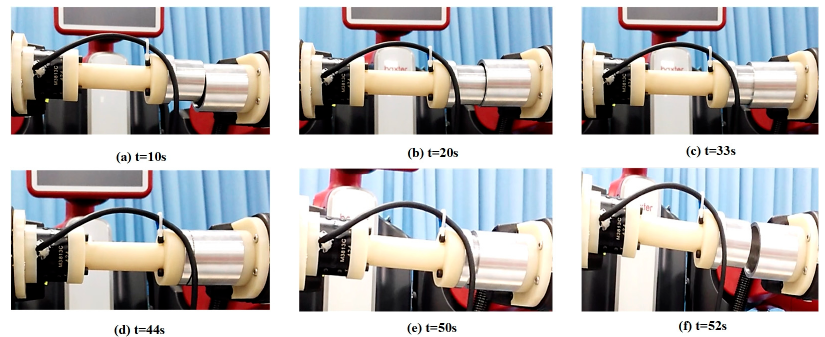
Figure 13. Round pieces: the process of peg-in-hole assembly with single-arm operation.